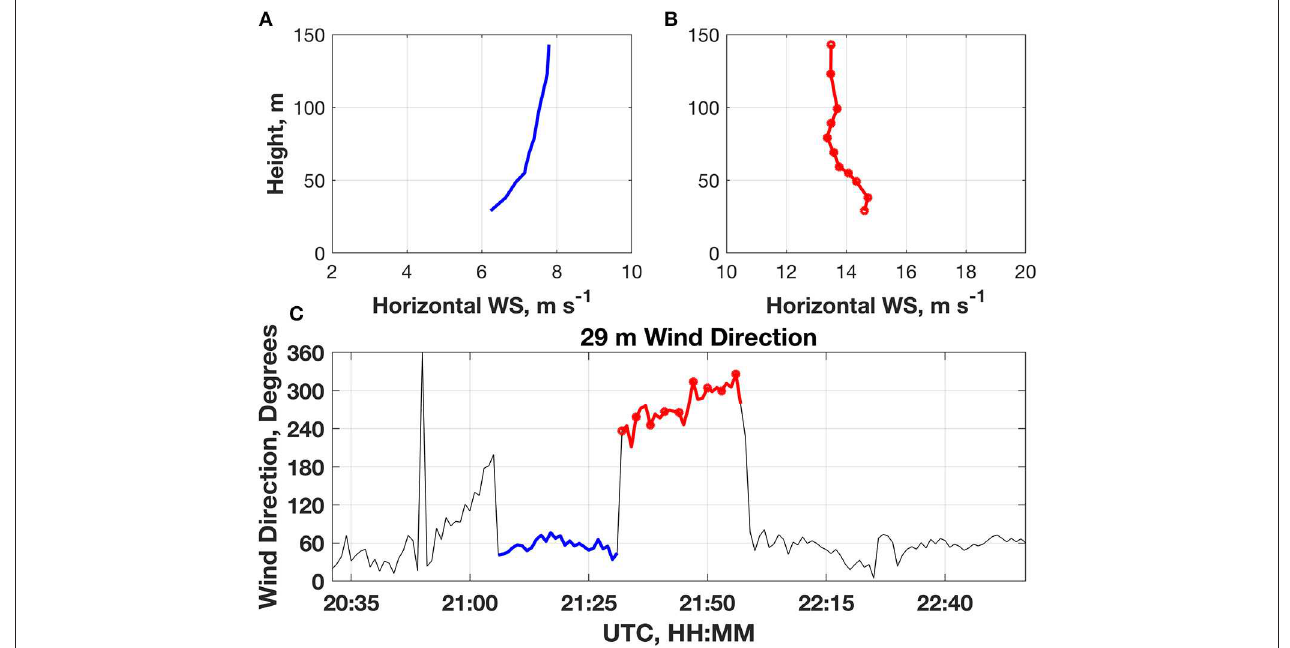
FIGURE 3 | Estimation of average inflow and outflow wind profiles for the 3 July 2017 thunderstorm event. (A) shows the average inflow profiles (blue) based on the blue highlighted region of the 29m wind direction in (C) . (B) Shows the average outflow wind profiles (red) from the red highlighted region of the 29m wind direction time history in (C)